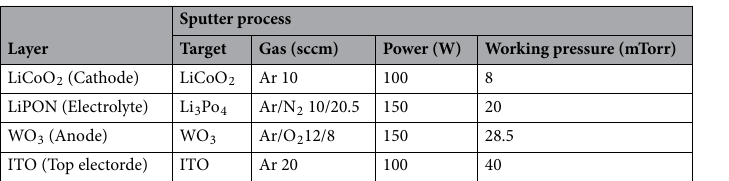
Table 1. Optimized T-SC device sputtering process conditions.